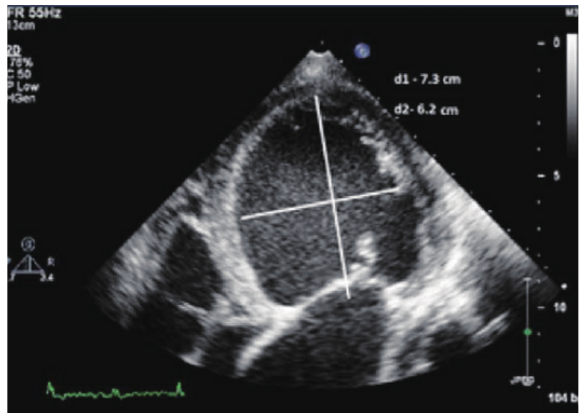
Figure 2 The apical four-chamber view: left ventricle is significantly enlarged and becomes spherical with longitudinal diameter of 73mm and transverse diameter of 62mm. The ratio of longitudinal to transverse diameter as spherical index (SI) is 1.2, which was less than the reference value of 1.5. The ventricular septum and left ventricular lateral wall become thinner with smoky echoes in left ventricle, suggesting slow blood flow.